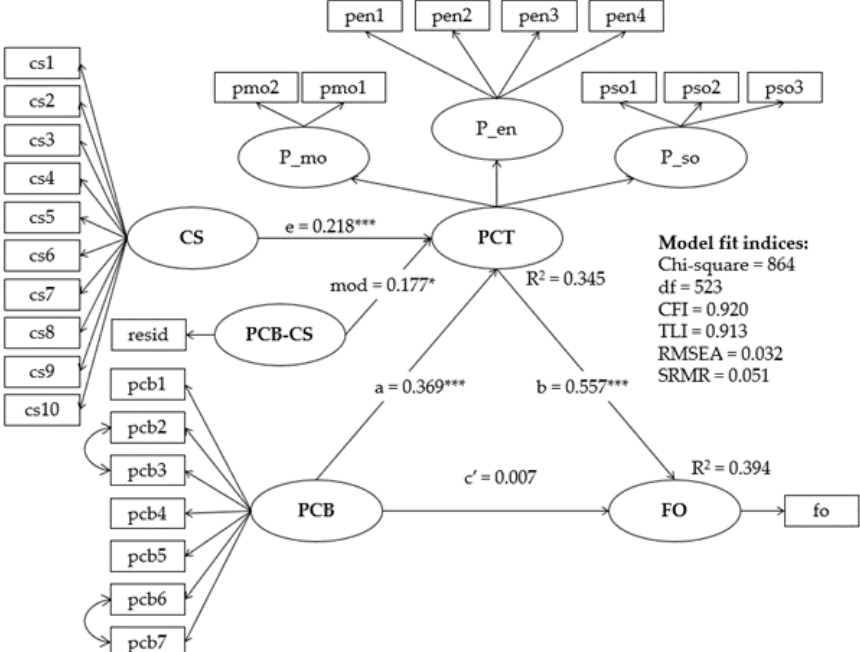
Figure 4. Standardized path coefficients of moderated mediation structural equation model (outcome variable = FO). * refers p < 0.01 and *** refers p < 0.001. Note. PCB = Perceived crime benefit, PCT = Proactive criminal thinking, P_mo = Mollification, P_en = Entitlement, P_so = Super optimism, FO = Future offending, CS = Crime strategy. PCB_CS = Interaction between PCB and CS.